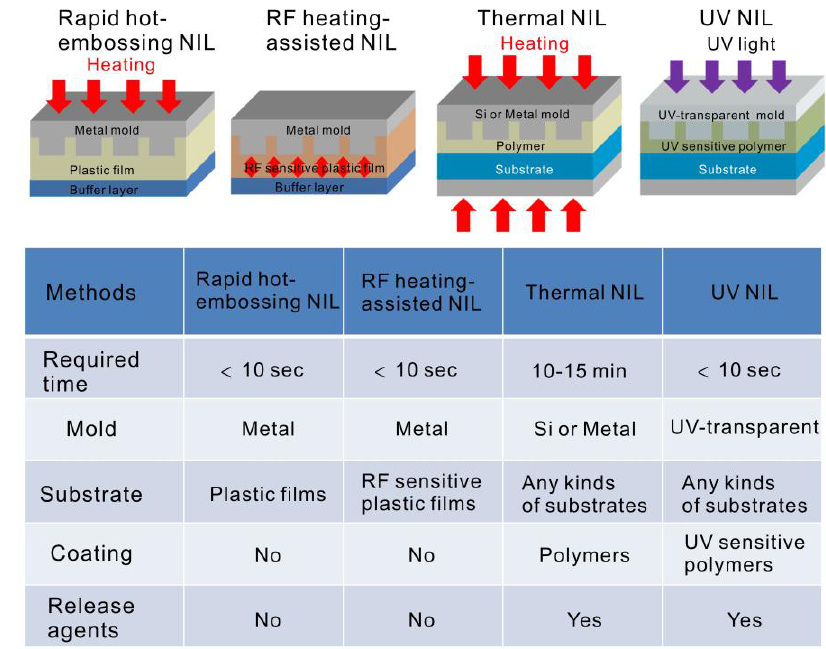
Figure 6. Comparison of various nanoimprinting methods.